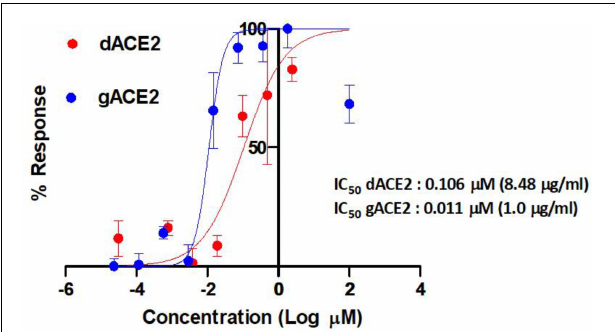
FIGURE 7 | Apparent activities of two distinct ACE2 derivatives produced in plants to RBDs plotted against half maximal inhibitory concentration (IC50) of authentic SARS-CoV-2 neutralization. The IC50 values of the gACE2 (glycosylated) and dACE2 (deglycosylated) were calculated using normalized optical density (OD) data obtained from quadruplicated test dilutions in GraphPad Prism v8.2 software (GraphPad). The OD values from untreated (cell control) wells were used as normalization standards. A non-linear regression analysis was performed using log (inhibitor) versus normalized response-variable slope. The R square values were recorded as 0.86 and 0.89 for dACE2 and ACE2, respectively. ACE2, gACE2, glycosylated ACE2; dACE2, plant produced deglycosylated